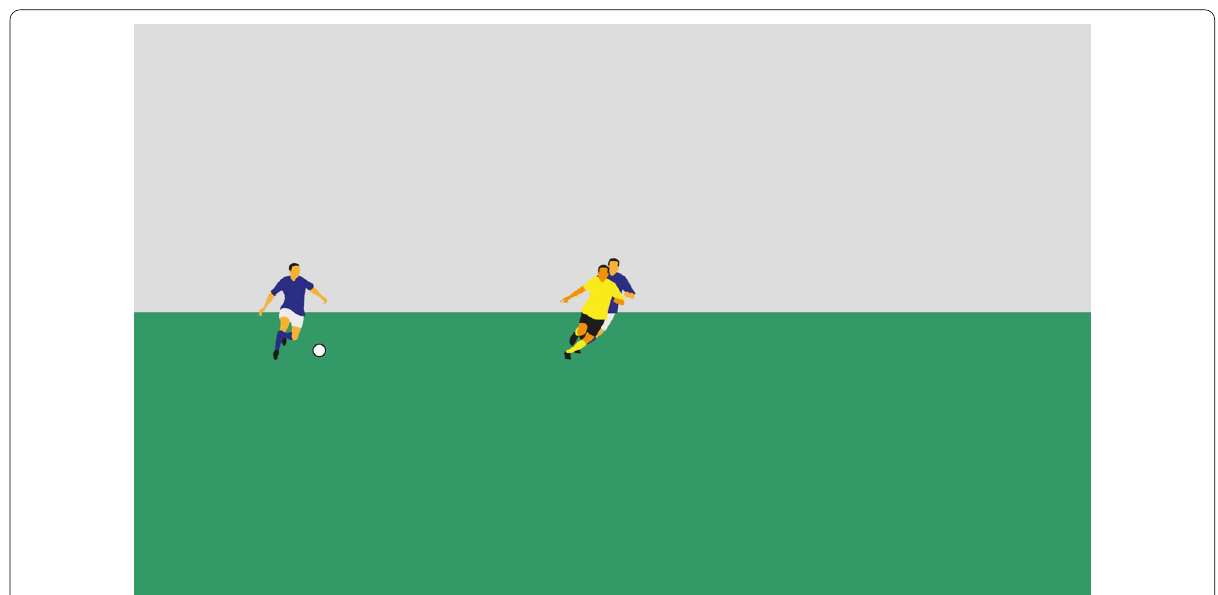
to the right of this condition. Third, different team pref- erences should lead to opposite patterns for blue versus yellow players, and these effects should be most visible in the most difficult conditions. In particular, support- ers of Borussia Dortmund should report the offside posi- tions of yellow forwards (unfilled circles in the right half of Fig. 2) less often than the offside positions of blue for- wards (filled circles in the right half of Fig. 2). In addition, supporters of Borussia Dortmund might also report the